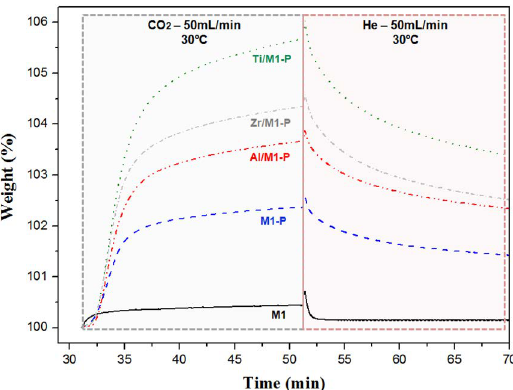
adsorption cycles of samples M1, M1-P, Al/M1-P, Figure 12. CO 2 Ti/M1-P and